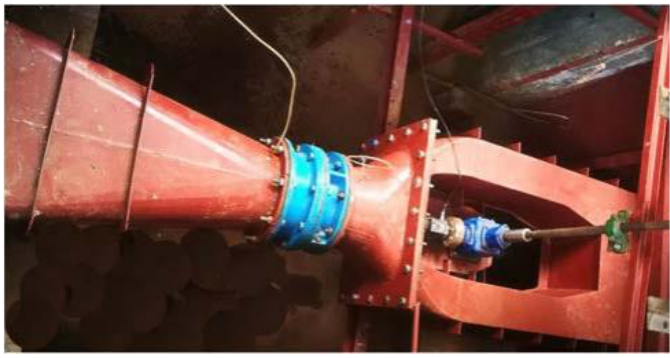
Figure 21. Model drawing of pump installation [80,81].